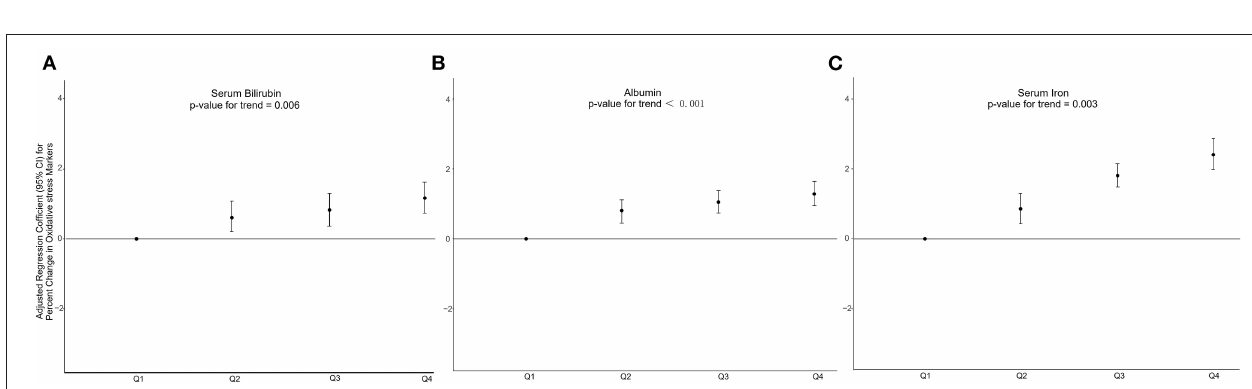
FIGURE 5 | Percent change in oxidative stress markers associated with increasing C-DII among study participants in model 3 for (A) serum bilirubin, (B) albumin, (C) serum iron. Model 3 adjusted for age, sex, race/ethnicity, cotinine exposure status, BMI, poverty-income ratio, body fat percentage and energy